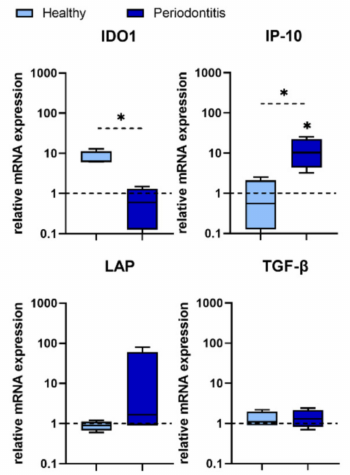
Figure 6. Expression of genes associated with immunomodulation in GMSCs treated with P. gingivalis . The basic level of each mRNA expression is counted as 1 (non-treated GMSCs) and is marked with a dotted line. The asterix above the boxes indicates the significant difference between non-treated and P. gingivalis treated H- or P-GMSC lines (* p < 0.05). The asterix above the line indicates the significant difference between H- and P-GMSCs treated with P. gingivalis (* p < 0.05); n = 4 in each